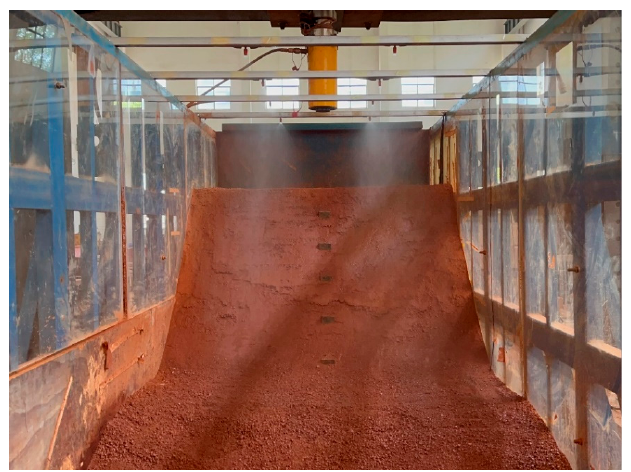
Figure 4. Schematic diagram of bamboo rhizomes’ embedment. Test G3 was a rainfall bamboo-rooted slope. A rainfall simulation system was used at the beginning of the test to apply rainfall conditions to the slope top, slope face, and slope toe locations. The rainfall intensity was 20 mm/h, and the duration was one hour. After rainfall, it was left for four hours to allow the water to penetrate completely before being loaded. This rainfall intensity and duration could ensure the infiltration of rainwater to the location of the soil layer where the bamboo rhizomes were located. The arrangement of sensors within the slope and the embedment of bamboo rhizomes were the same as in test G2. The rainfall simulation system is shown in Figure 5.